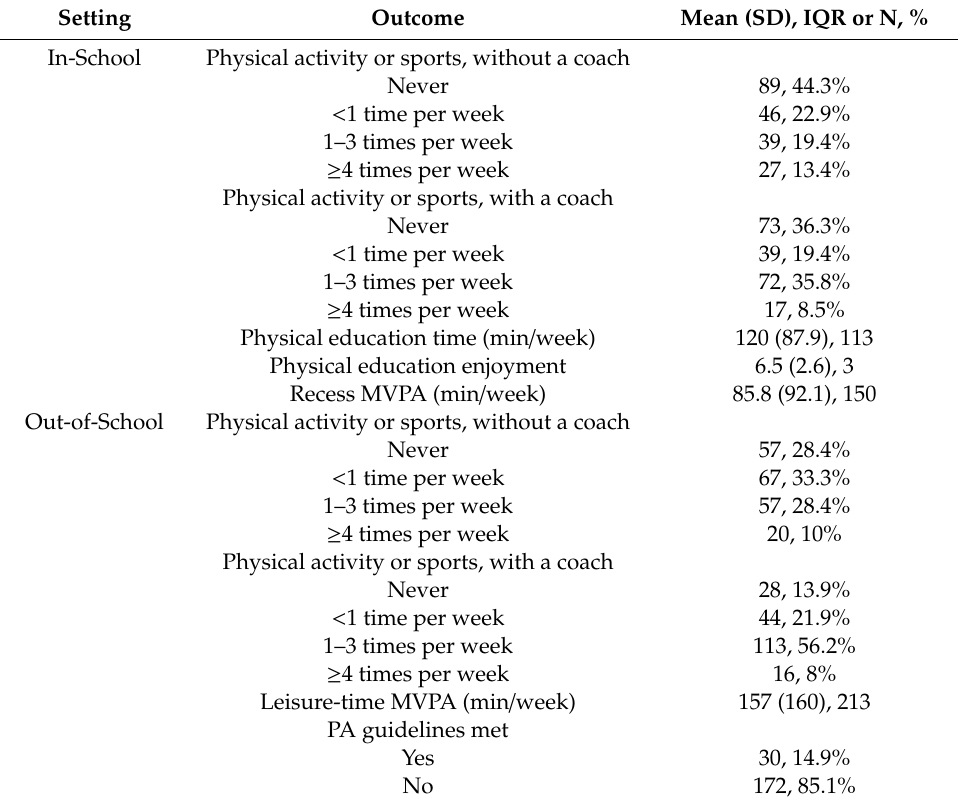
Table 2. Participation in in-school and out-of-school physical